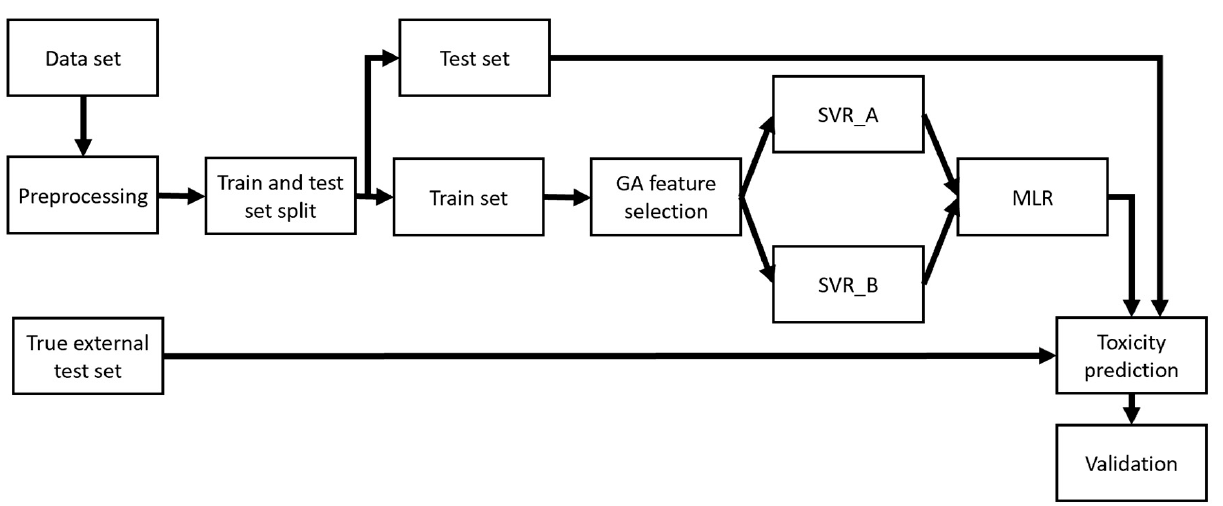
Figure 1. Demonstration of the methodology used to develop QSAR models.